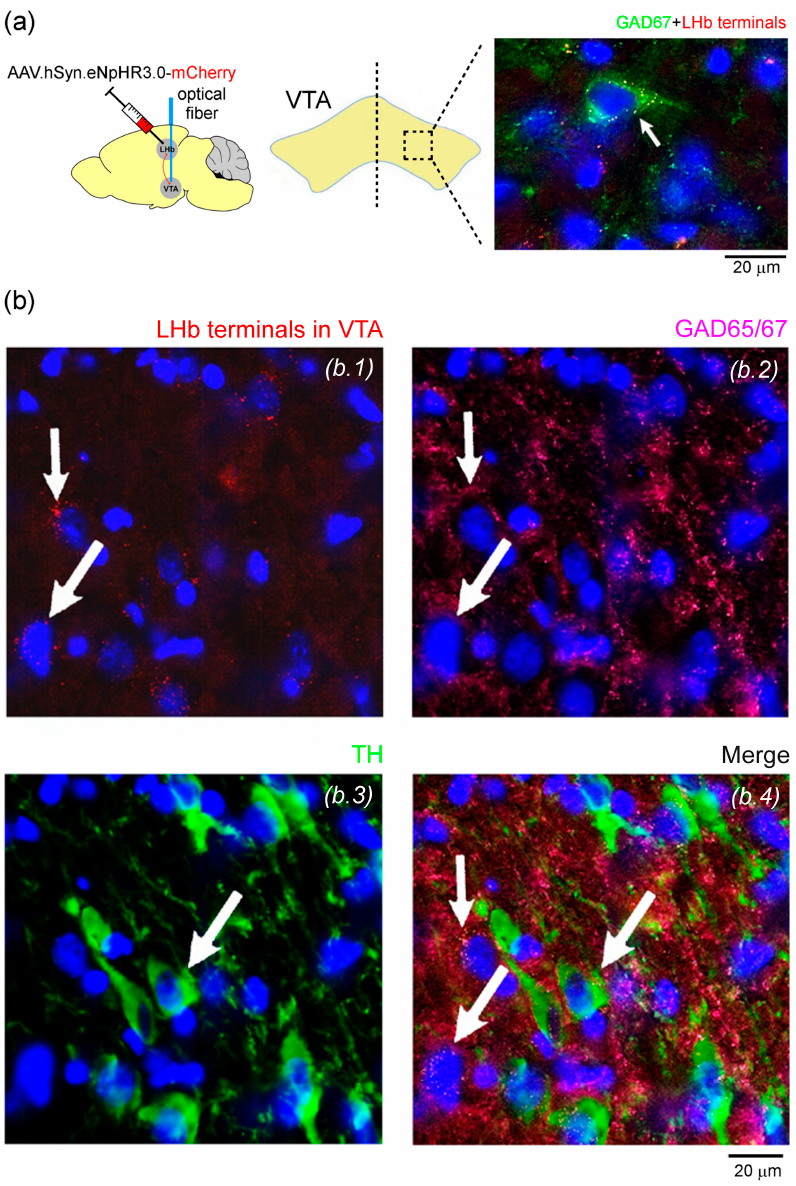
Figure 3. Tissue validation of LHb eNpHR3.0-expressing neurons targeting into the VTA. Immunofluorescent images showing eNpHR3.0-expressing axonal terminals of LHb neurons targeting into the VTA GABAergic cells. ( a ) Colocalization of LHb terminals with VTA GAD67-